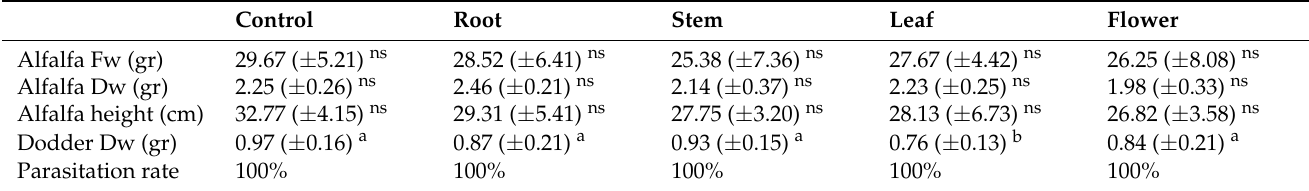
Table 3. Effect of N. meyeri extracts from different organs of on C. campestris and alfalfa vegetative traits and parasitation rate after attachment. Numbers represent means and ± standard deviations calculated for each phenotype, respectively. ANOVA analyses (n = 3, p -value < 0.05) were performed for each trait. Different letters indicate statistically significant differences. ns: not significant; Fw: fresh weight; Dw: dry